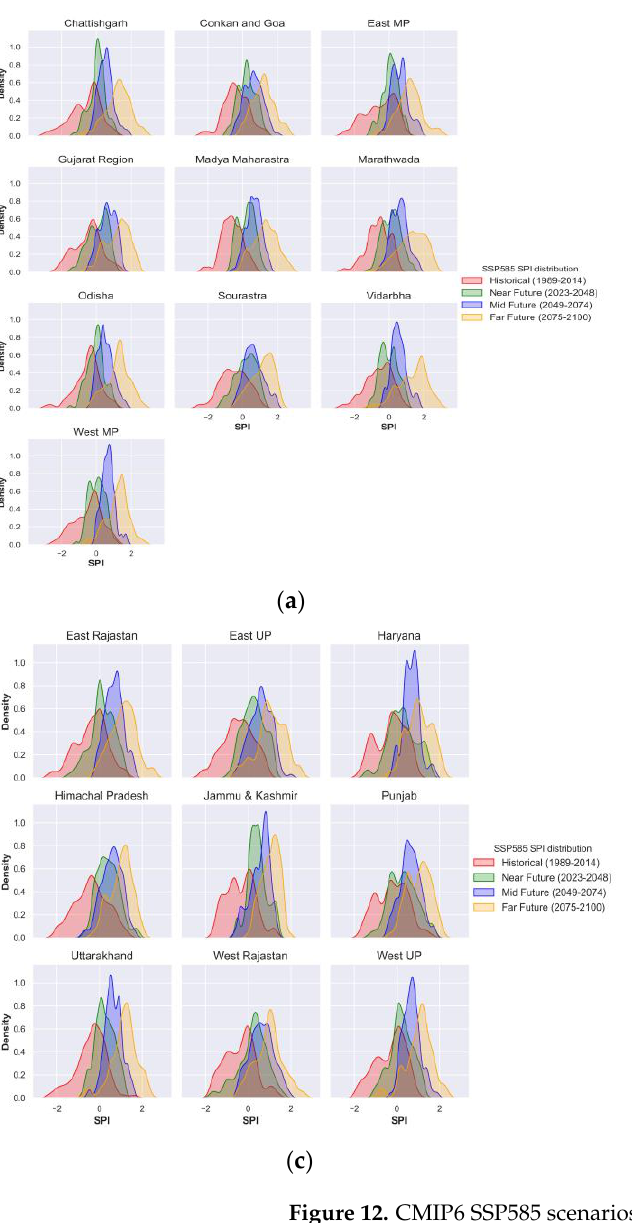
Figure 11. CMIP6 SSP245 scenarios 12-month Standard Precipitation Index (SPI) PDF plot at mete- orological subdivision level ( a ) Central India, ( b ) East and Northeast India, ( c ) Northwest India, and ( d ) South Peninsula India for near, mid, and far future.